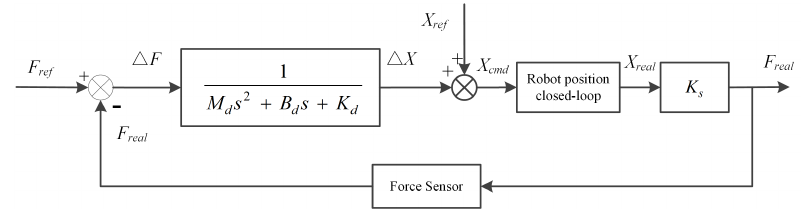
Figure 2. Robot manipulator impedance-control system